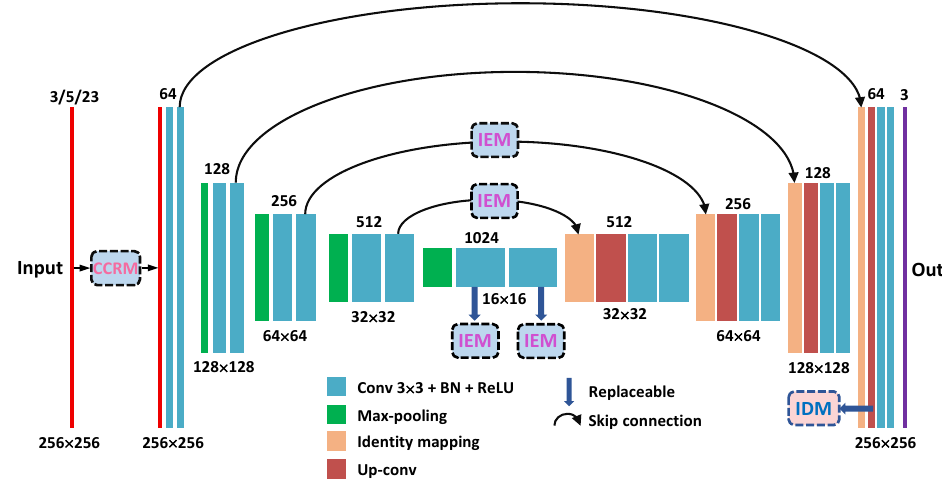
Figure 7. Overall framework of the proposed Ir-UNet in this